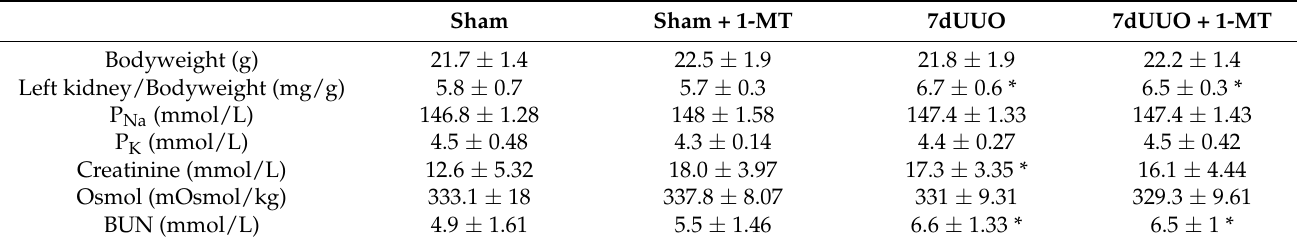
Figure 3. Cortical IDO protein expression increases following UUO. Mice were subjected to 7 days of unilateral ureteral obstruction (UUO). Afterward, indoleamine 2,3-dioxygenase (IDO) protein expression was studied using western blot (n = 8–10). Data are presented as mean ± SEM. * p < 0.05. Table 3. Functional data after UUO and 1-MT treatment.